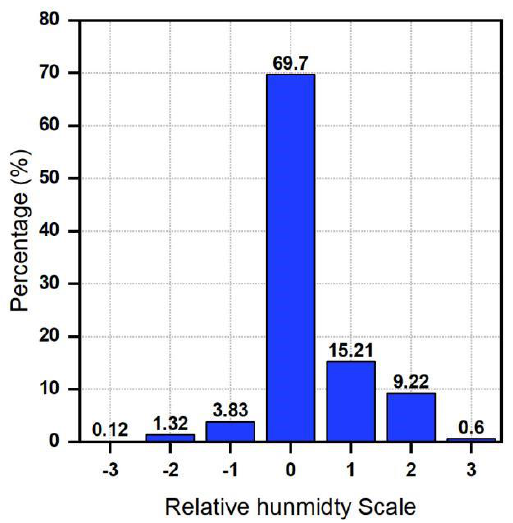
Figure 9. Relative humidity sensation vote.